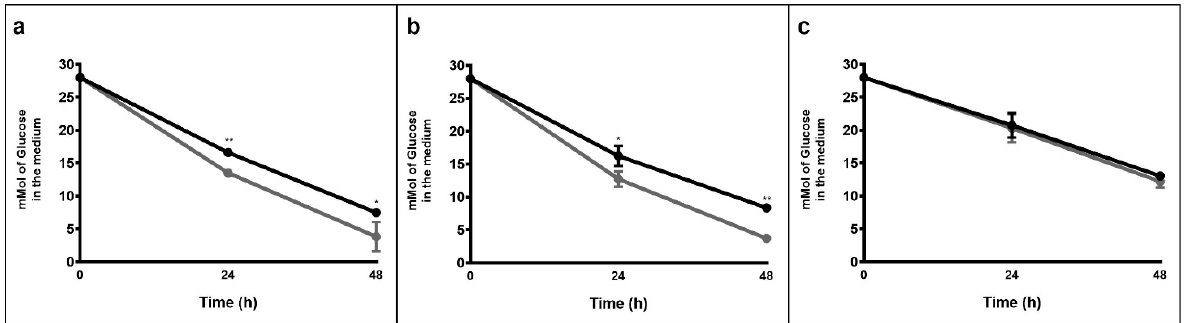
Figure 2. Glucose consumption of Tnea ( a ), Trq7 ( b ), and Tmar ( c ) after 24 and 48 h, under N 2 (black bars) and CO 2 (gray bars) conditions. Asterisks indicate significant differences: *, p ≤ 0.05; **, p ≤ 0.001.